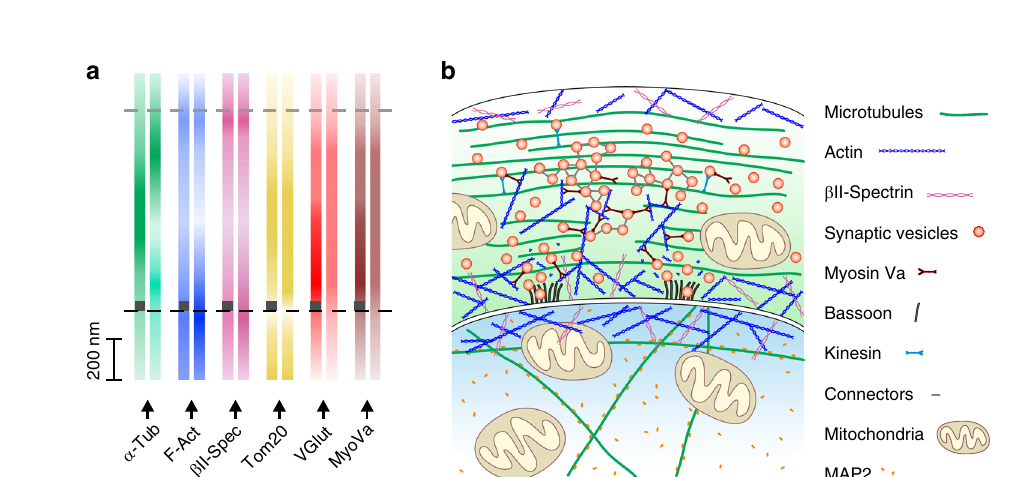
Fig. 3 Multiplex dSTORM of the calyx of Held synapse. a Schematic representation of the calyx of Held synapse with the cross-section revealing multiple swellings with active zones (AZ) and zoom-in delineating borders relevant for analysis. b Cartoon illustrating the topology of adjacent calyces as represented in c . c STORM images showing 16 targets of the same section acquired in 10 consecutive staining rounds (SR) using one or two spectral channels (Ch). d High registration precision (3 – 47 nm) of images shown in b achieved throughout all SRs. e Magni fi ed images of cross-section of calyces (as depicted in a ). Homer, bassoon, and WGA stainings con fi rm imaging plane-perpendicular orientation. f Presynaptic distribution of selected proteins analyzed and averaged over 9 – 15 calyces from 3 to 5 experiments. Calyx borders derived from WGA staining. g Distances of α -Tub peak, fi rst and second F-Act peak (p1, p2), and VGlut1 peak to synaptic membrane differed signi fi cantly (** p ≤ 0.01; *** p ≤ 0.001, one-way ANOVA). h – j Differential protein distribution within regions containing or lacking AZs (see inset in h ). h Synapse-proximal regions contain more synaptic vesicles (SVs) (VGlut1 staining) at AZ sites as compared with extra-AZ regions. i Less polymerized actin in AZ-proximal regions. j More MyoVa at AZ sites, correlating with VGlut1 pro fi le. k , l Example of single AZs supports correlation between SV and MyoVa distribution and illustrates individuality of AZs. m Colocalization matrix showing Pearson ’ s r coef fi cients (exact values, see Supplementary Fig. 14) between all combinations of 14 analyzed proteins at AZ-proximal (upper matrix part) and AZ-free (lower part) calyx regions. Asterisks denote statistical signi fi cance for colocalization of selected protein pairs (* p ≤ 0.05; unpaired two-tailed Student ’ s t test). Scale bars correspond to 5 µ m in c and 500 nm in e . Scatter plot g shows mean ± SD. Note that in addition to representative images in c and e another six and three experiments were carried out, respectively, with similar designs and outcomes. For exact sample numbers, see Supplementary Table 5. Source data, including exact p values for g and m , are provided as a Source Data fi le.